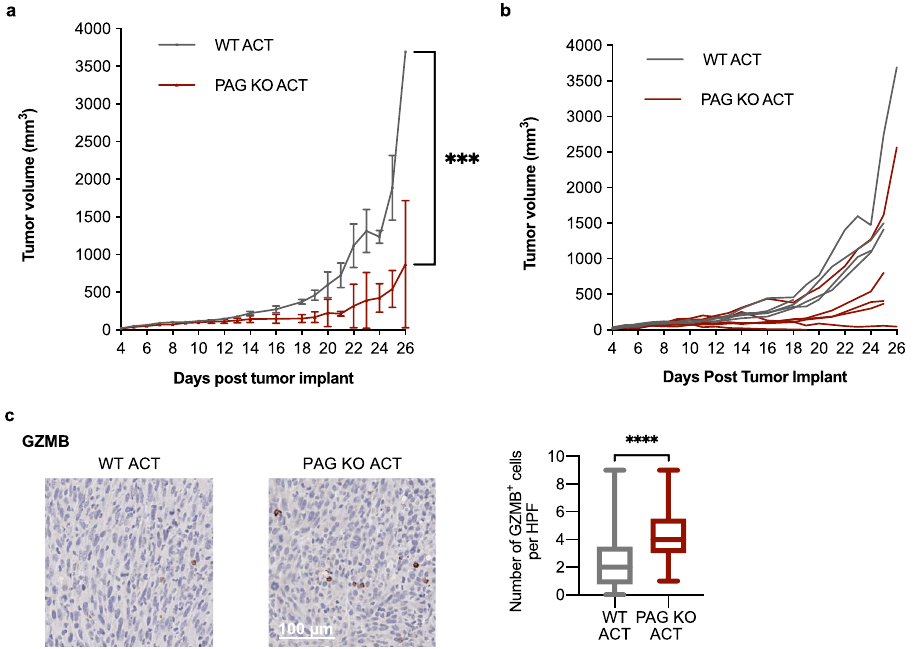
Fig. 7 PAG depletion in T cells is suf fi cient for an anti-tumor effect. MC38 tumors were implanted in WT mice that received two adoptive transfers of 8.5 × 10 6 WT or KO CD3 + T cells (six mice per group). a , b Daily tumor growth as calculated from measurement by digital caliper. Mean ± SEM ( a ); individual mice ( b ). c Immunohistochemical and quanti fi cation for granzyme B + (GZMB) in fi ltrating cells in MC38 tumors from adoptive transfer recipient mice at